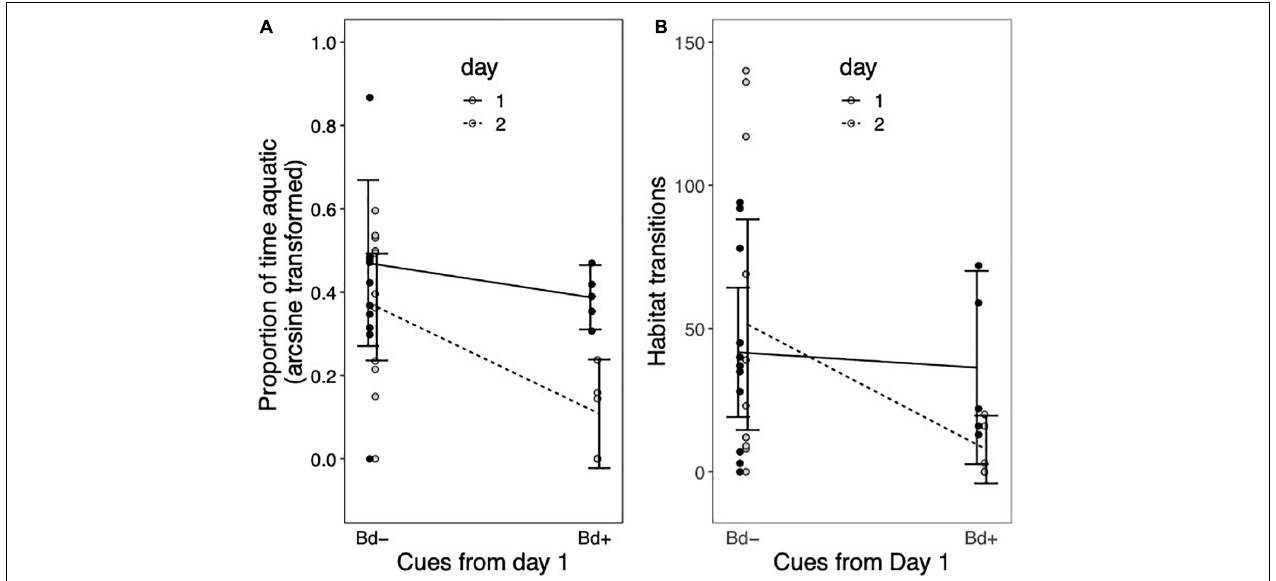
FIGURE 1 | Effects of Day 1 cues on immediate and future aquatic activity. (A) The proportion of total time that females spent aquatically (arc-sine transformed) and (B) the number of transitions between aquatic and terrestrial habitats on day 1 (black points, solid line) and day 2 (gray points and dashed line) is shown. Newts are classified according to whether they experienced water on Day 1 that was previously used by Bd -exposed conspecifics (Bd+) or water with no cues of Bd (Bd–). Lines are drawn between the mean value for each class, and error bars denote the 95% confidence